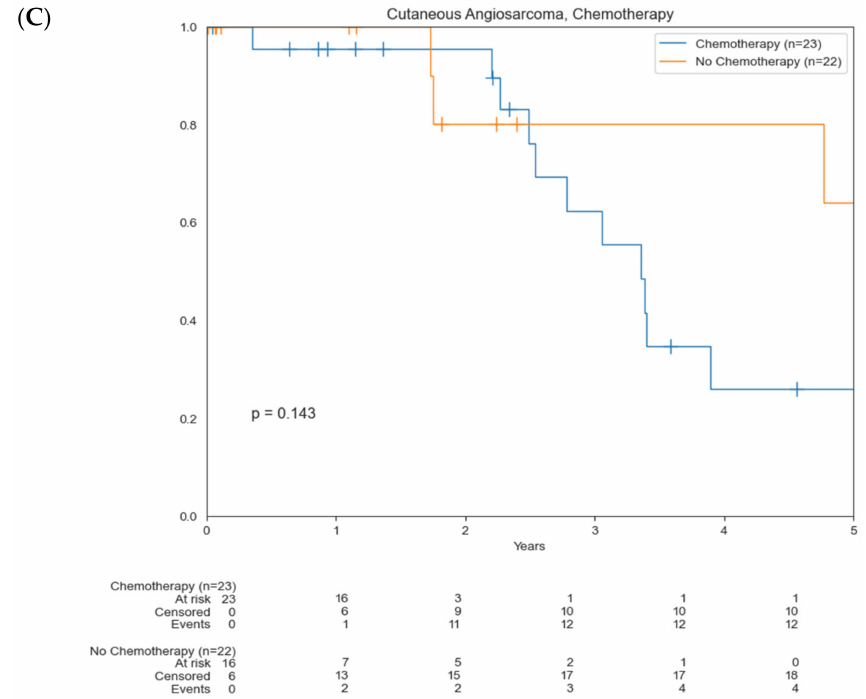
Figure 3. Kaplan–Meier curves comparing OS based on treatment modality. ( A ) Surgical resection